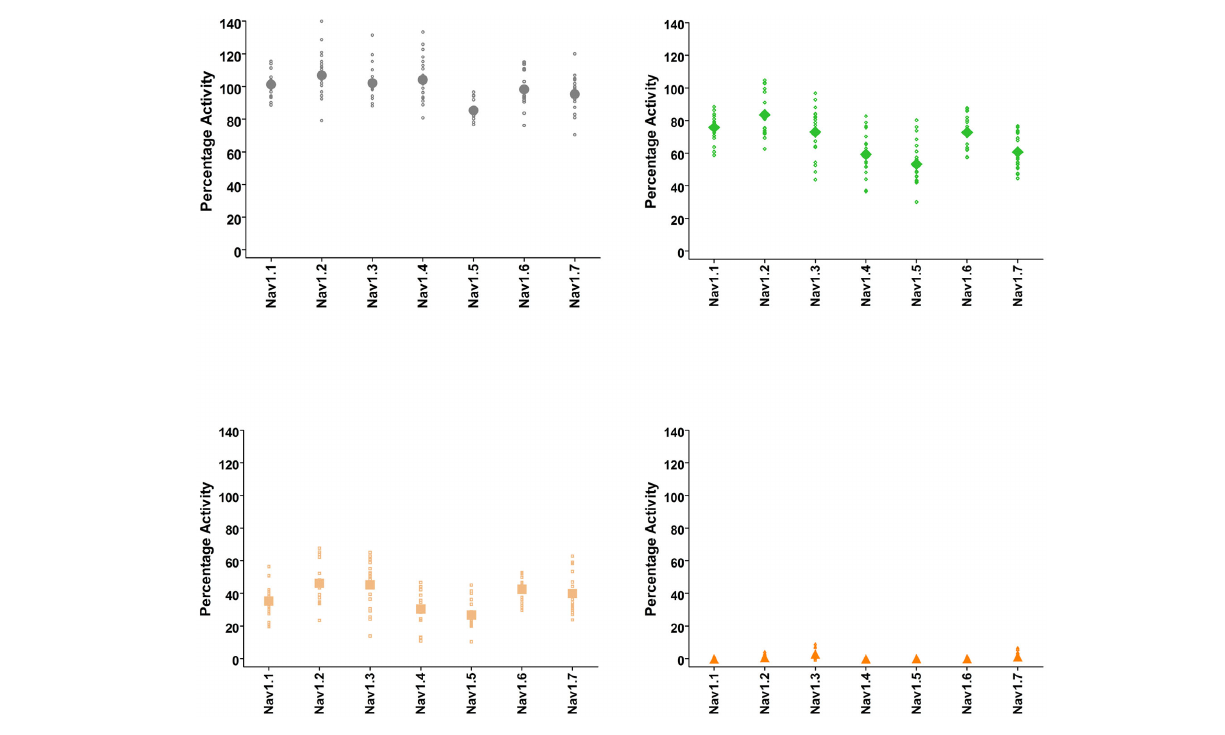
FIGURE 3 | Quality-control data for Nav1.1, Nav1.2, Nav1.3, Nav1.4, Nav1.5, Nav1.6, and Nav1.7 assays collected over a 6month period of time using IonWorks Quattro. Vehicle control was external buffer with 0.3% DMSO final concentration and reference inhibitors consisted of tetracaine (Nav1.1), lidocaine (Nav1.2, Nav1.3, Nav1.4, Nav1.5, Nav1.6), and lamotrigine (Nav1.7). Data shown were calculated from Pulse 1 and